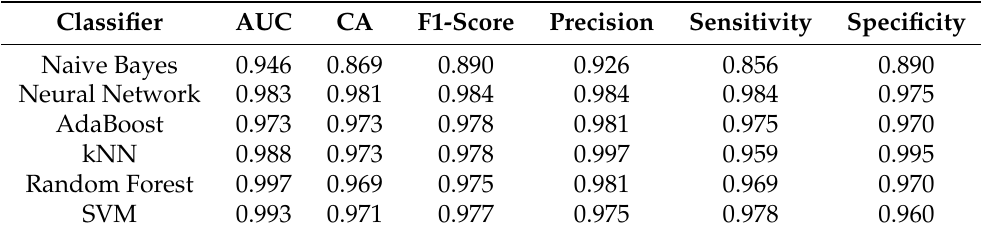
Table 10. Results of Evaluation Measures for Area Under the Curve (AUC), classification accuracy (CA), F1-Score, Precision, Sensitivity, and